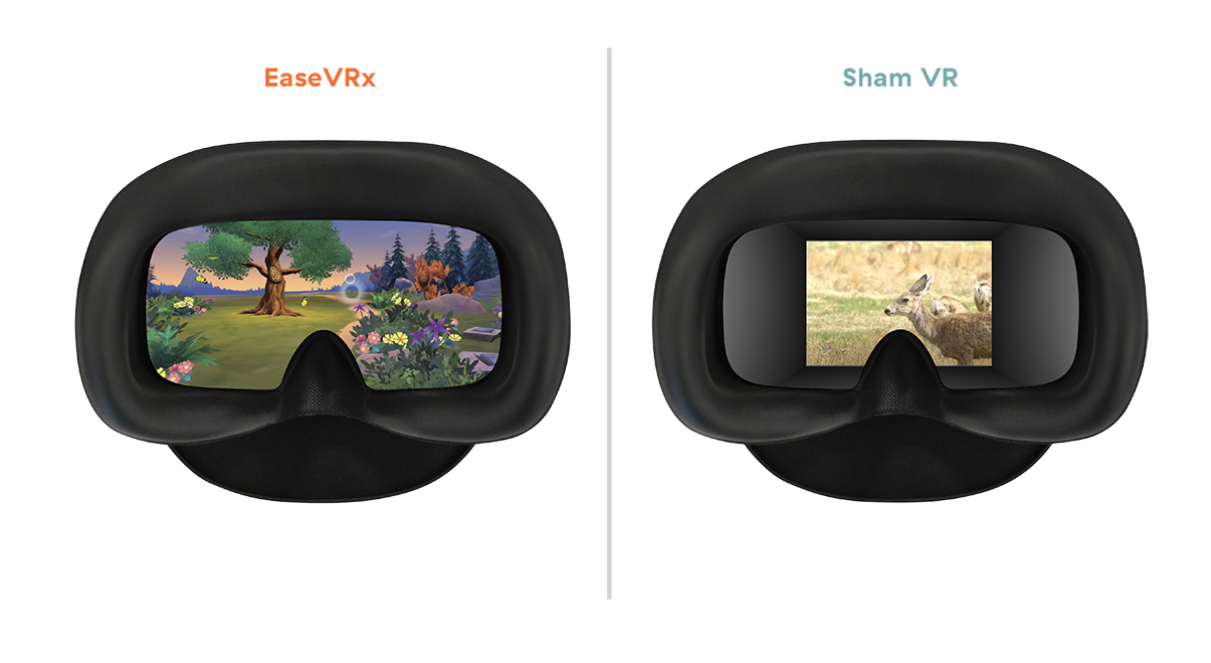
Figure 2. Visual display of EaseVRx (skills-based, interactive, 3D) and Sham VR (non-interactive 2D nature